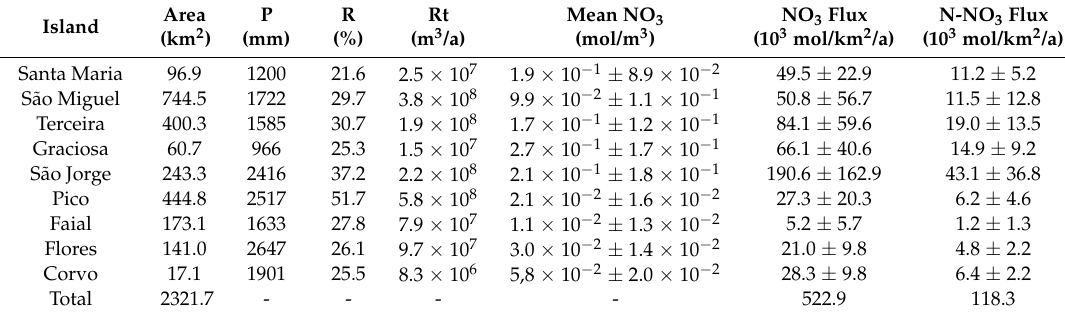
Table 1. NO 3 flux calculated for each island in the Azores archipelago (annual precipitation (P) and weighted average recharge rate (R) from [52]; Rt is the total recharge estimated for each island). Area P Island (km 2 )